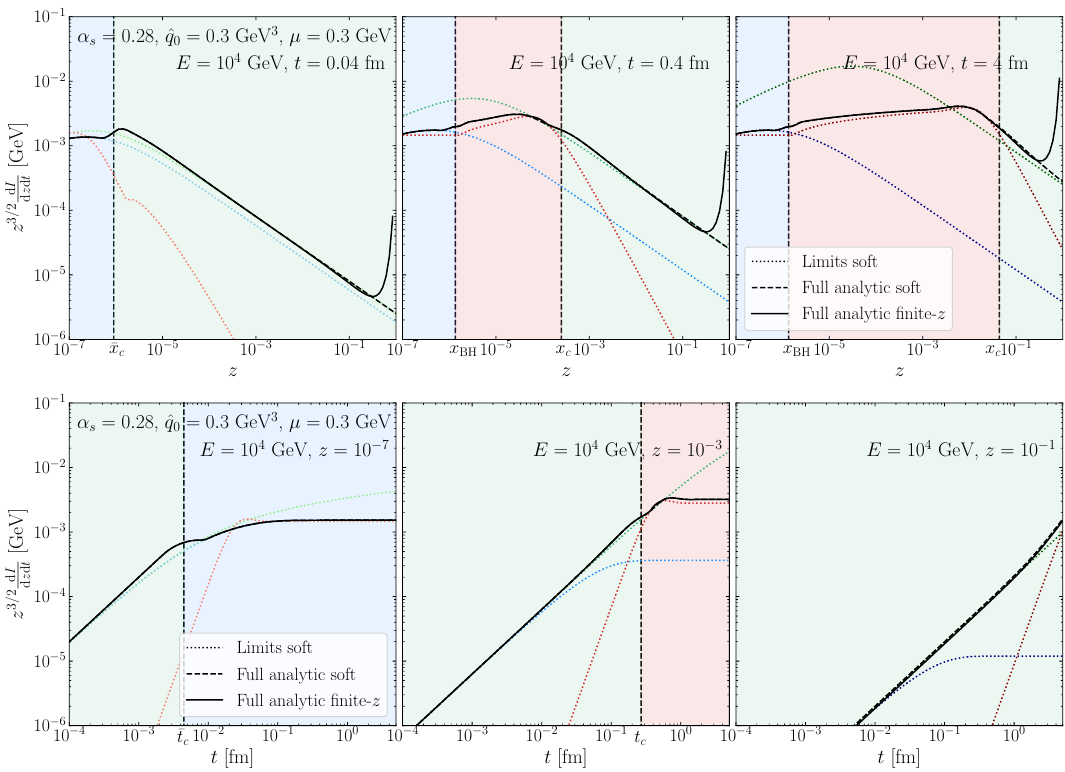
Figure 8 . The medium-induced rate from eqs. (4.9), and (3.64) for gluons for different emitted energy and propagation time (black dashed lines). The black solid lines include finite- z corrections. The dotted lines are the N r = 1 , HO and N = 1 lines according to figure 7. The color shading corresponds to figure 3i.e. denoting the dominant scattering processes. The parameters correspond to λ = 0 . 06